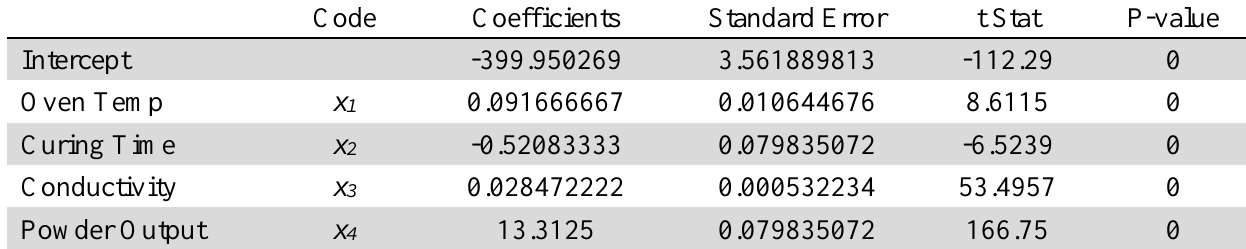
Coefficient table for thickness mean